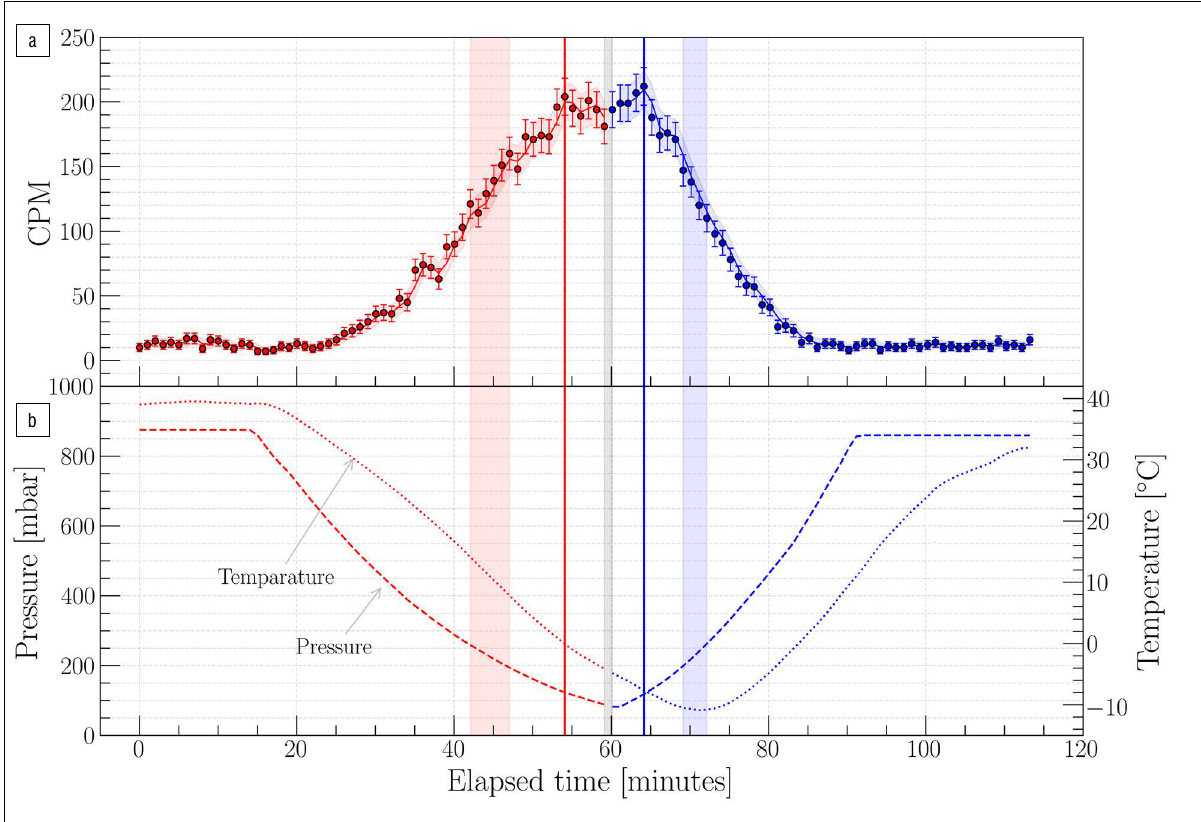
Figure 7: (a) The counts per minute (CPM) and (b) atmospheric pressure and temperature are shown as a function of the elapsed time from launch. The red and blue colours represent the ascend and descend phases, respectively, while the grey shaded area represents the burst altitude area. The red and blue vertical shaded areas in the ascend and descend phases represent the measurements at the aircraft cruising altitude between 10 km and 12 km. The blue and red thin vertical lines represent the RP-max before and after the burst altitude,